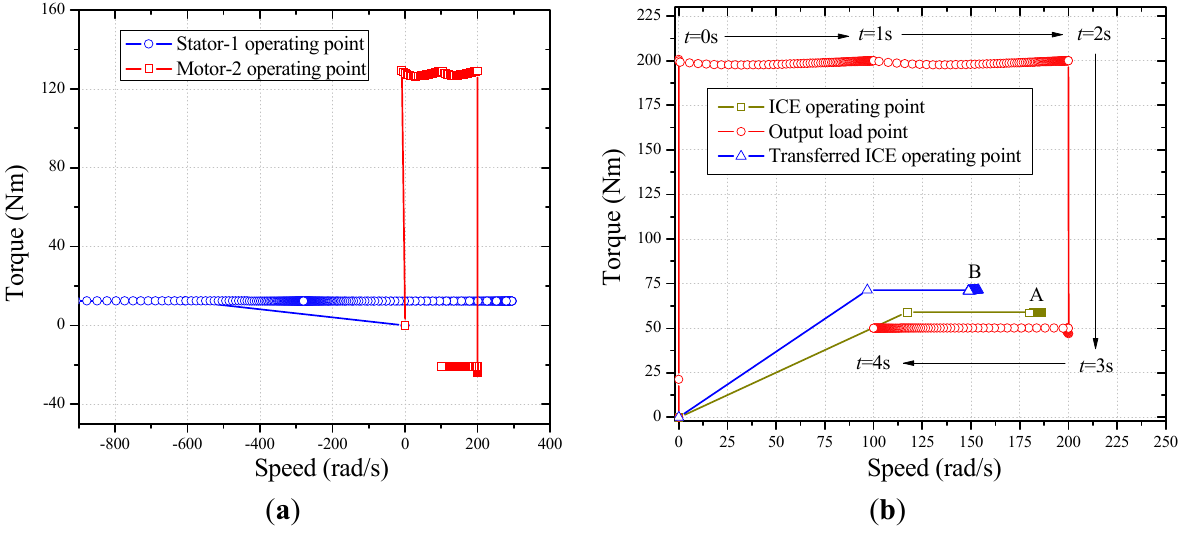
Figure 8. Historical speed-torque points: ( a ) Stator-1 and motor-2 operating points; ( b ) ICE, output load and transferred ICE operating